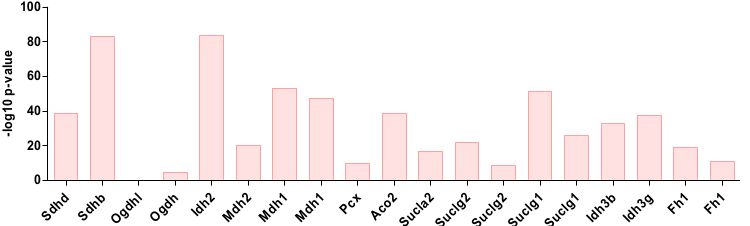
Figure A2. Significantly changed genes enriched in different KEGG pathways (represented by p - values) in progenitor-like cells cultured in vitro, compared to pancreatic single cells. Each column represents the mRNA level of the tricarboxylic acid cycle-related enzymes. As shown, all of the tricarboxylic acid cycle-related enzymes are up-regulated in progenitor-like cells.